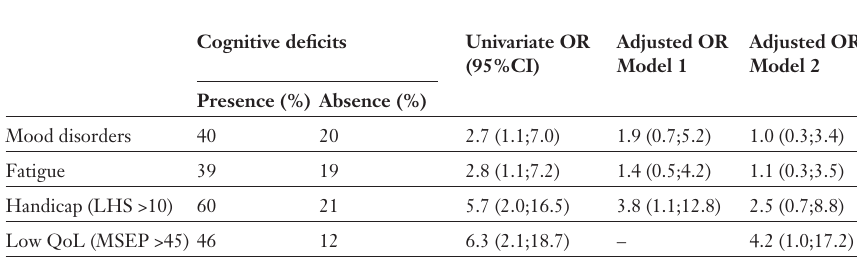
Predictive prevalence of cognitive deficits according to each of the 4 factors (mood disorders, fatigue, degree of handicap and QoL) using uni- variate and multivari- ate regression. In univariate analysis, cognitive impairment showed the strongest link with low QoL (OR = 6.3, 95%CI [2.1;